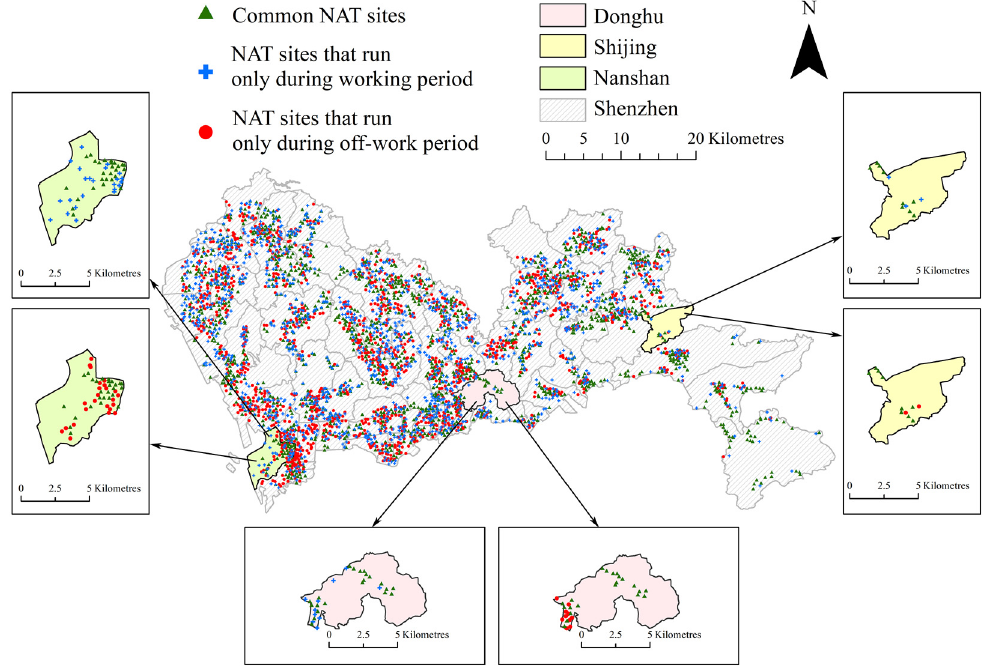
Figure 12. Map of different types of NAT sites in Shenzhen. Table 3. Data statistics of the population covered by NAT sites service